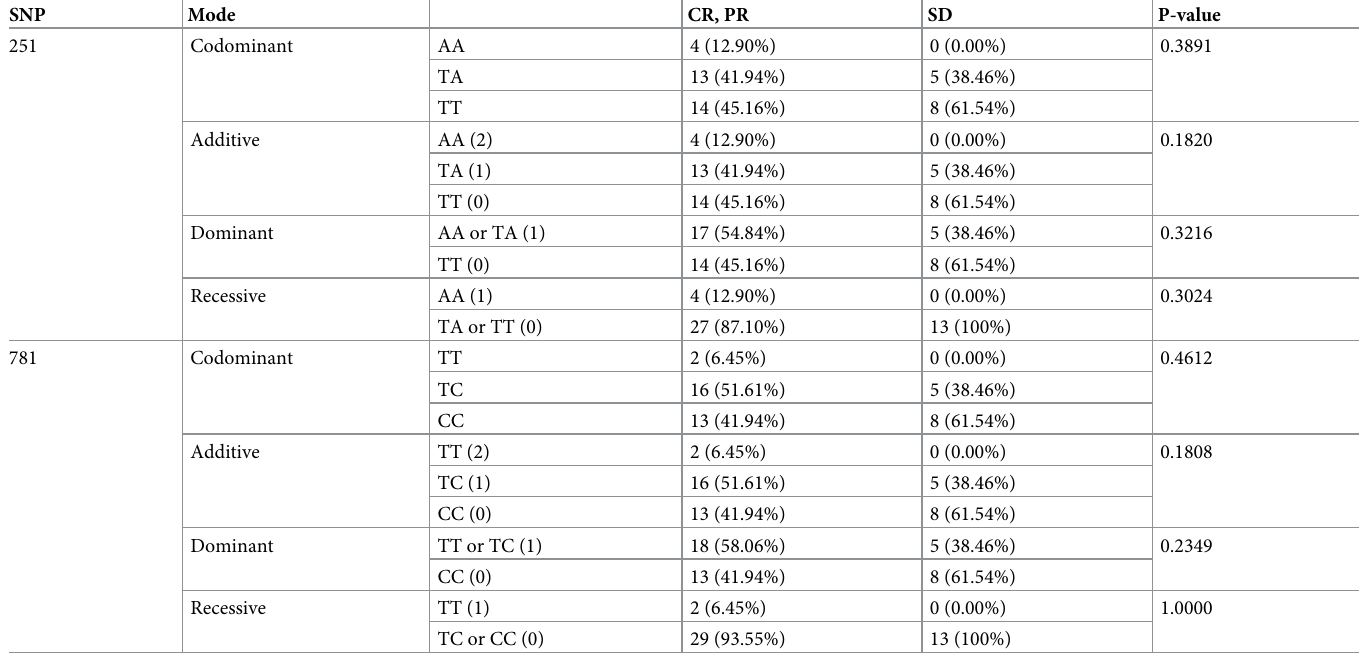
Table 5. Tumor responses according to genotyping of